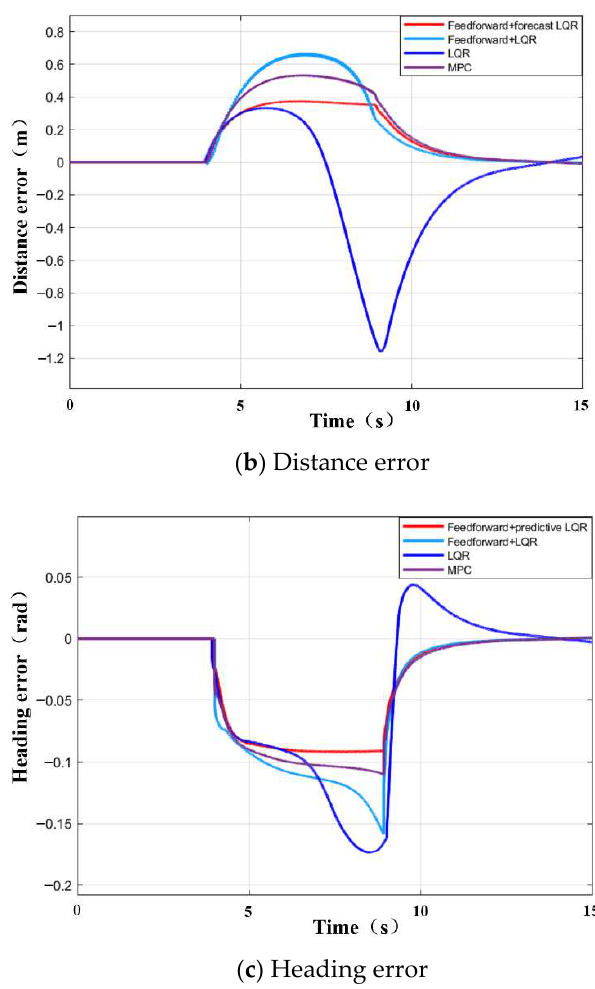
Figure 8. Simulation test results of roundabout conditions.